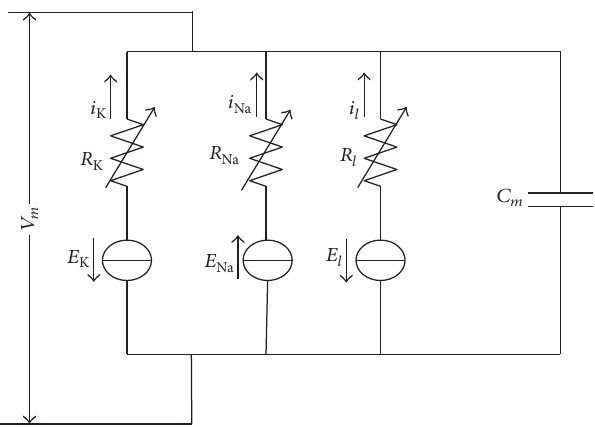
Figure 1: Circuit of H-H